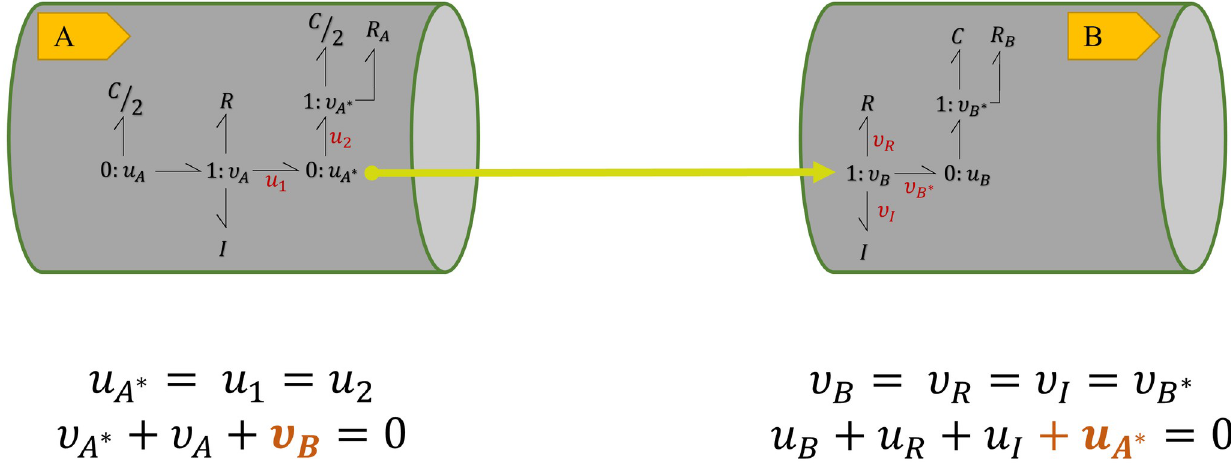
Fig 5. Conservation equations at the terminal junctions in two coupled bond graph modules. v B in B is added to the conservation equation at 0 : u A � junction in A and u in A is added to the conservation equation at 1 : v junction in B . Each terminal junction’s v or u in each module is added to the other A � B module’s conservation equation, representing the addition of a bond.